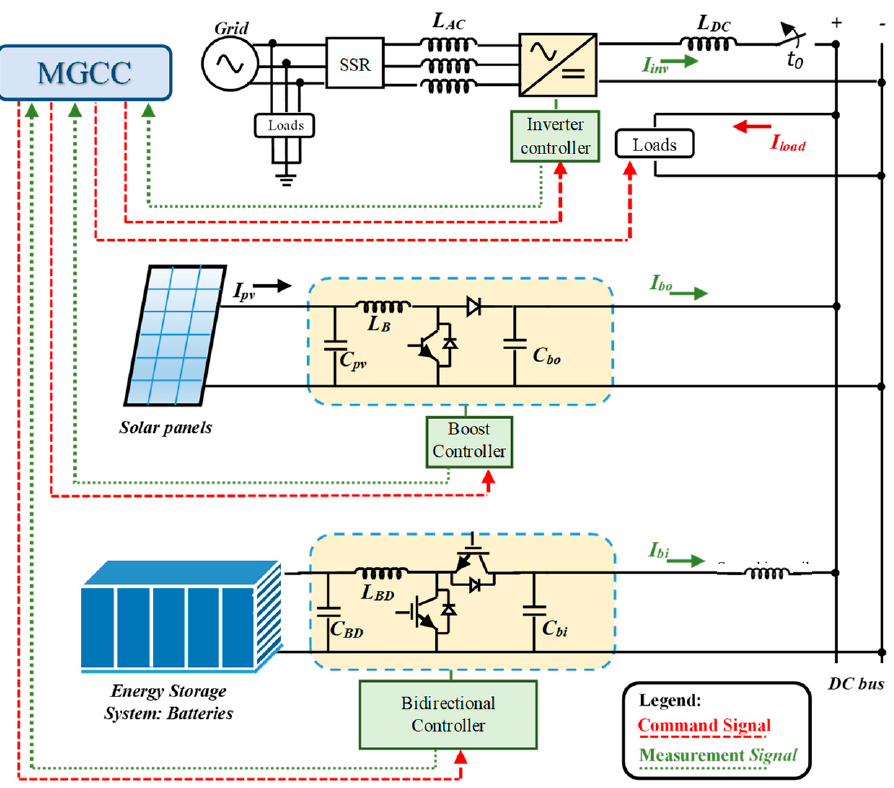
Figure 6. DC Microgrid model understudy. Table 2. Inductances and Capacitance of the Converters of the DC microgrid (MG). Converter